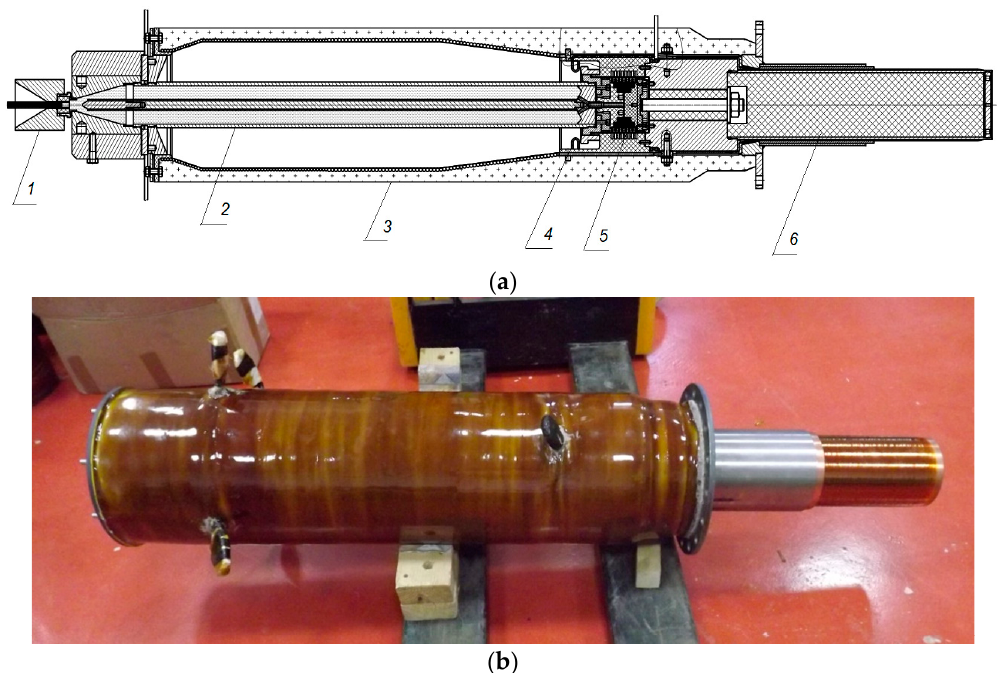
Figure 6. ( a ) General view of the EMG. 1—initiator unit, 2—copper liner, 3—helical EMG, 4—solid-state closer of circuit S c , 5—explosive breaker- S b , and 6—current collector. ( b ) Photos of EMG.